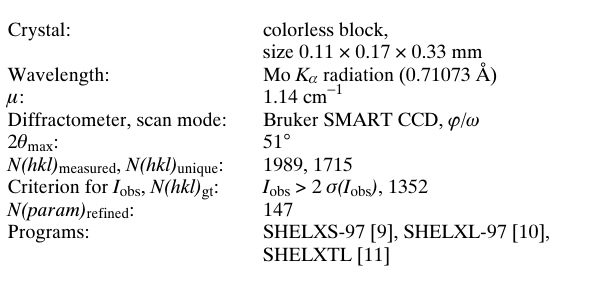
Table 1. Data collection and